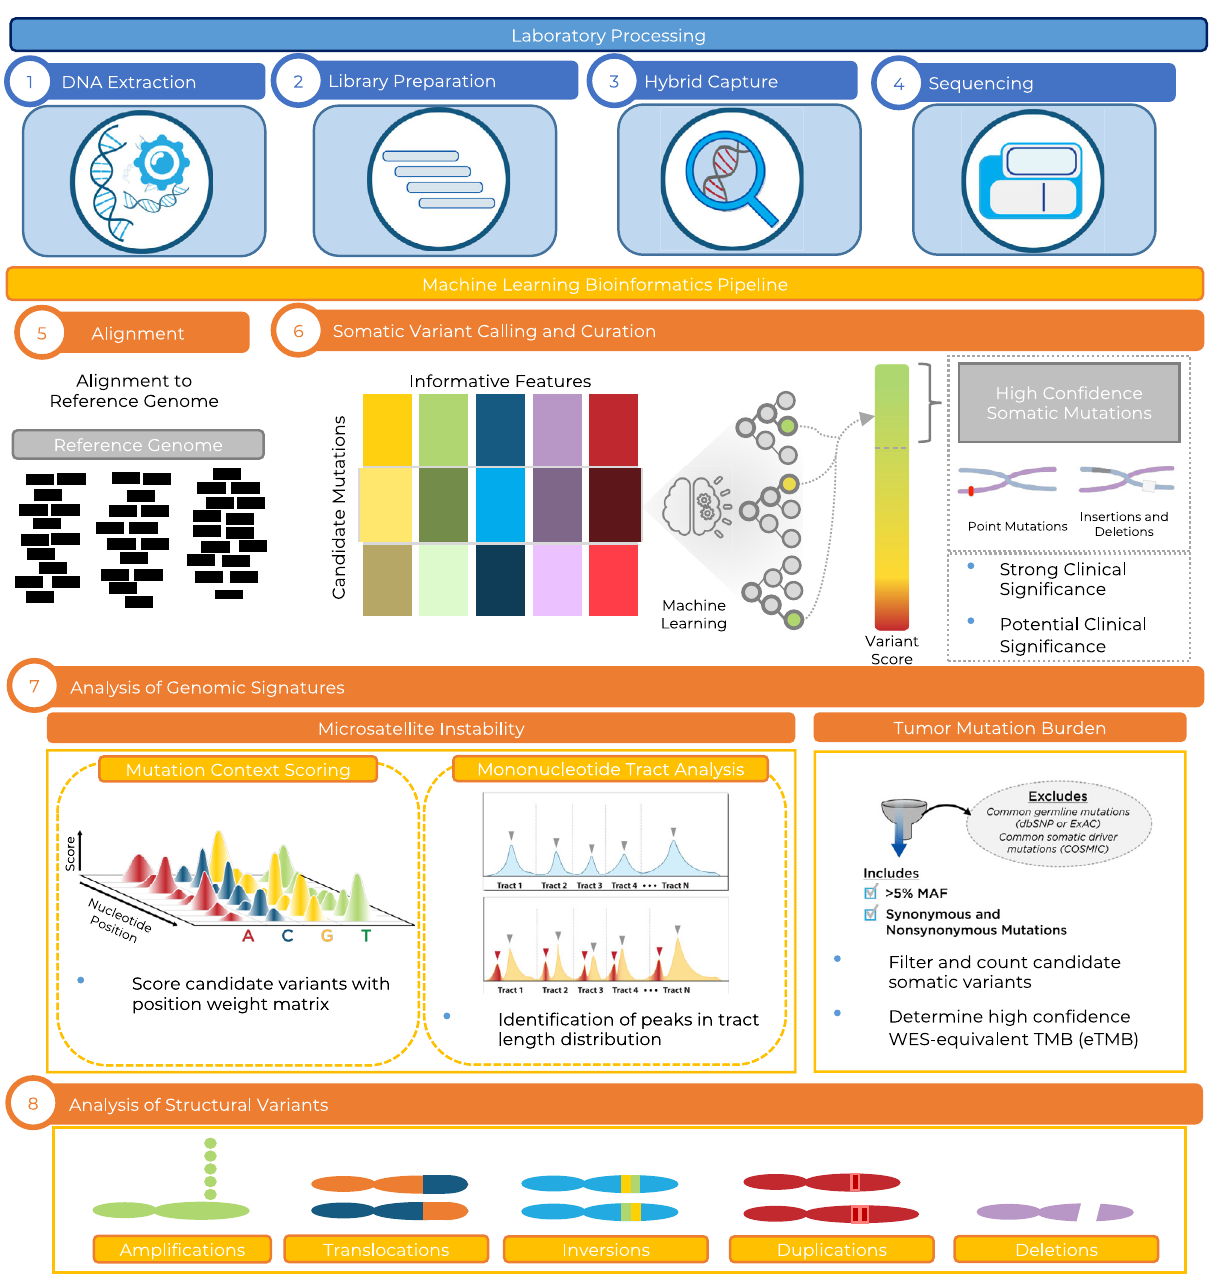
Fig. 1 Overview of sample preparation and analysis for determination of sequence and structural alterations, TMB, and MSI by elio tissue complete. Genomic libraries were prepared using DNA extracted from cell line or FFPE tissue, and following hybrid capture and PCR ampli fi cation, DNA libraries were sequenced using the Illumina NextSeq. Next-generation sequencing data were analyzed using the VariantDx bioinformatics pipeline through alignment to the human reference genome assembly for the identi fi cation of sequence mutations, including single base substitutions (SBSs) and insertions/deletions (indels). Candidate variants were fi ltered through the PGDx Cerebro algorithm, designed to distinguish genuine somatic mutation calls from technical artifacts 23 and used to determine an elio-predicted exome tumor mutation burden (eTMB) score. Microsatellite status was determined using 68 mononucleotide tracts and speci fi c sequence mutation contexts. Structural variants were identi fi ed with the Digital Karyotyping (DK) 29 and Personalized Analysis of Rearranged Ends (PARE) 29 algorithms. TMB tumor mutation burden, MSI microsatellite instability, MAF mutant allele fraction, WES whole- exome